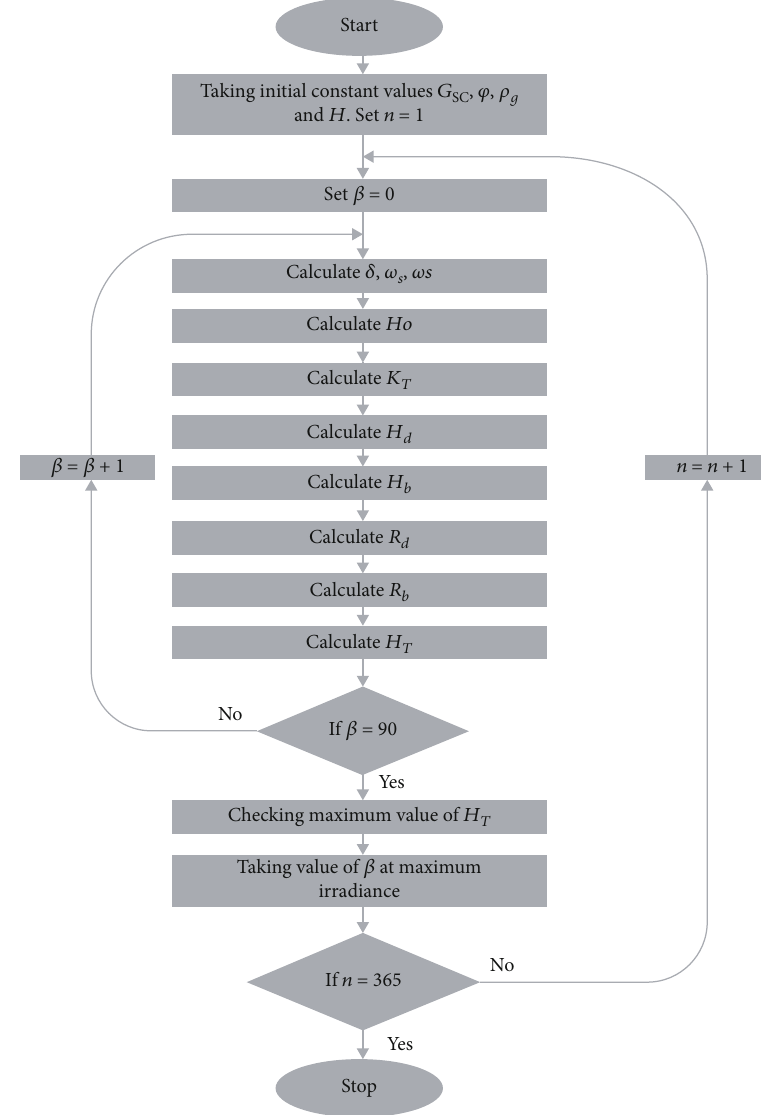
Figure 1: Flowchart for fi nding optimal tilt